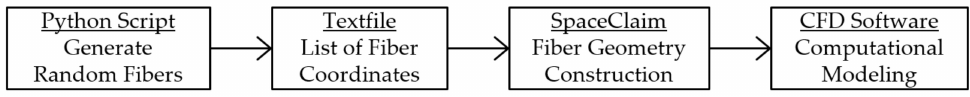
Figure 2. Methodology for random fiber generation and filter geometry construction.